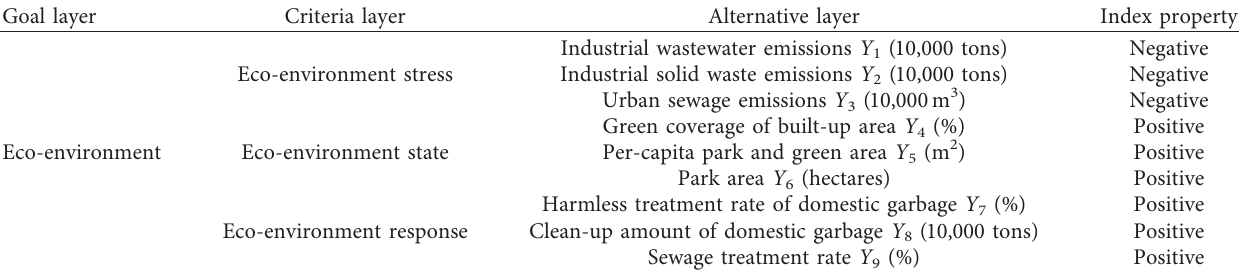
Table 4: CES of eco-environment.